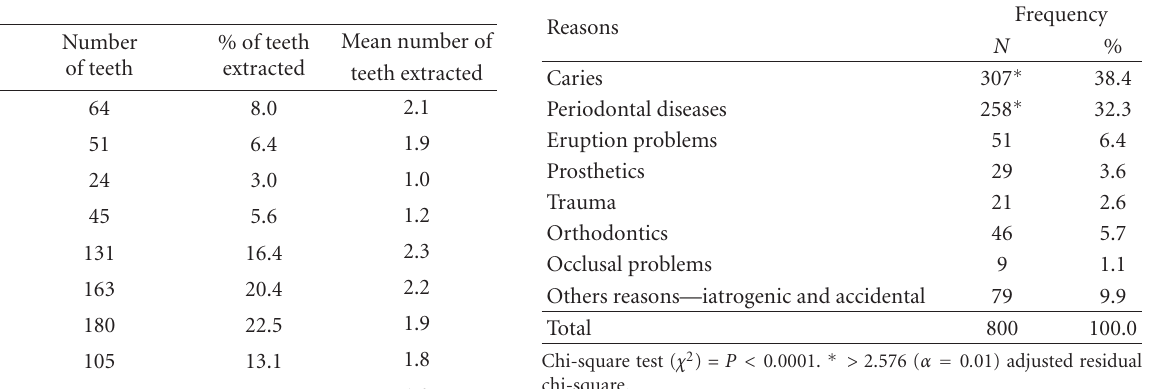
Table 3: Number and percentage (%) of teeth extractions by age group.